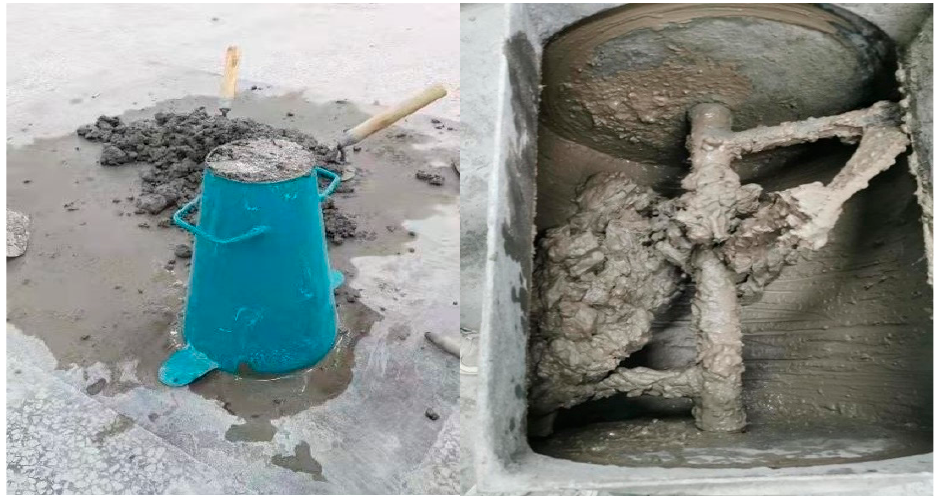
Figure 5. Cement block